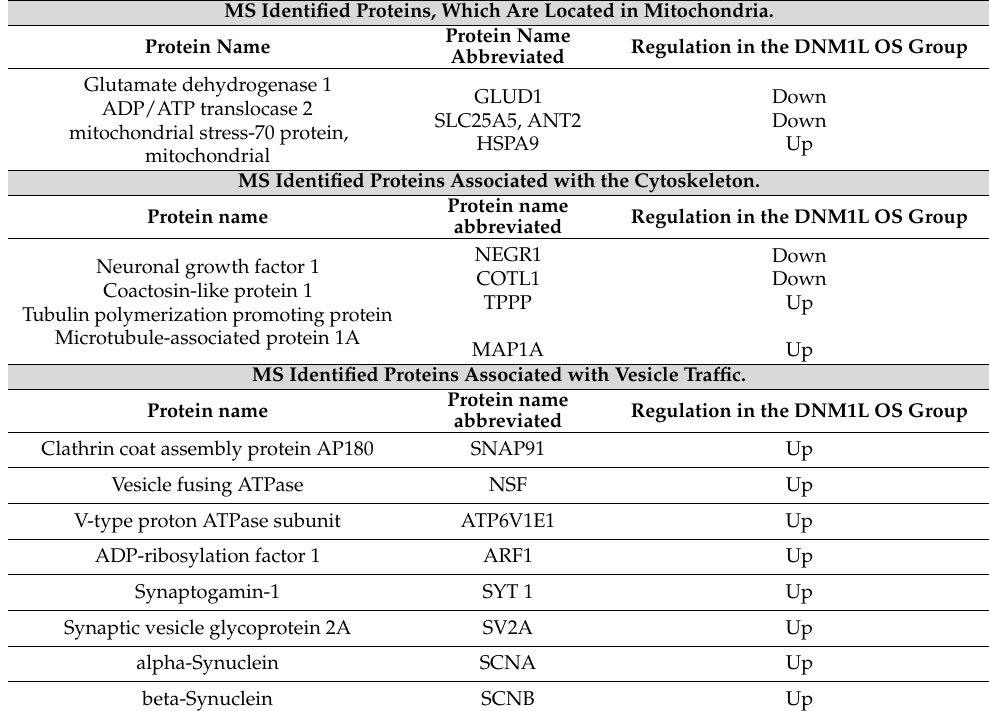
Table 1. MS identified proteins, categorized by subcellular location or association. MS Identified Proteins, Which Are Located in